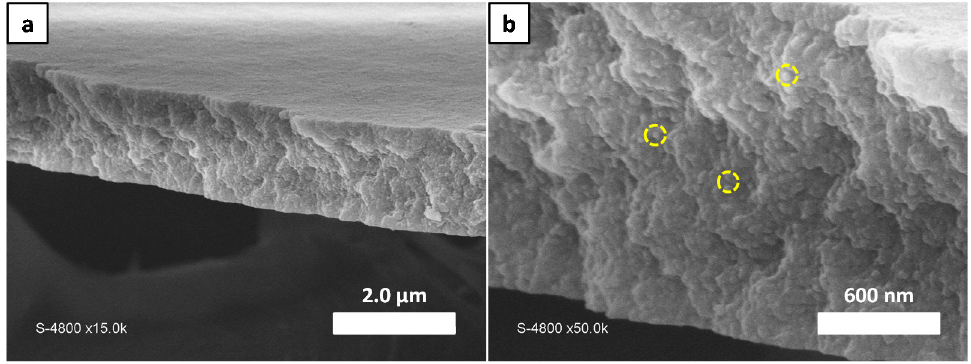
Figure 3. SEM images of the detached thin film after spin coating ( a ) Film cross section ( b ) Enlarged image of ( a ). Yellow doted circles highlight the presence of the spherical micelles inside the film.